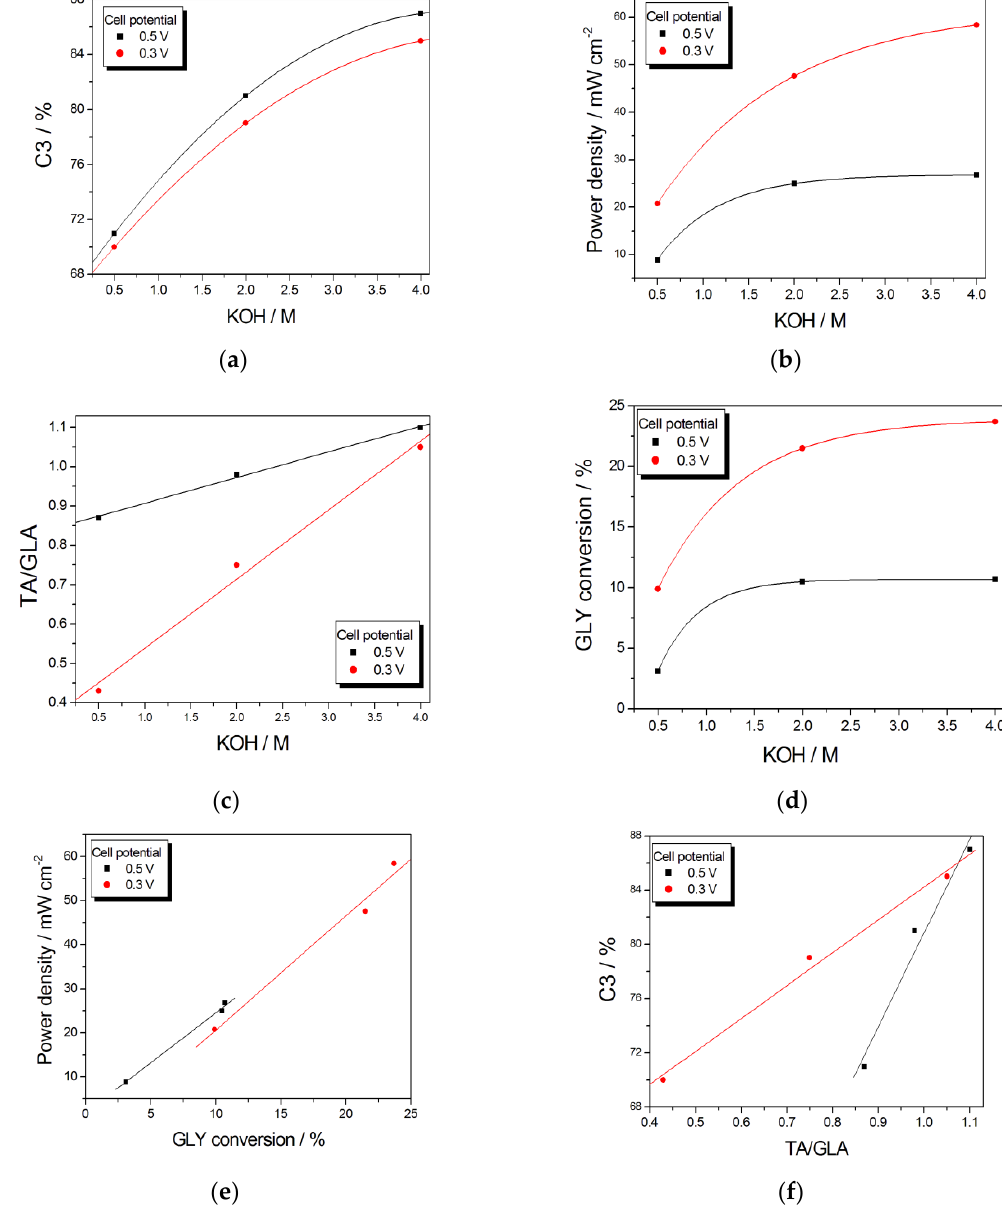
Figure 10. Dependence of C3 selectivity ( a ), power density ( b ), TA / GLA ratio ( c ) and GLY conversion ( d ) on [KOH] in the fuel; dependence of power density on GLY conversion ( e ), dependence of C3 selectivity on TA / GLA ratio ( f ).